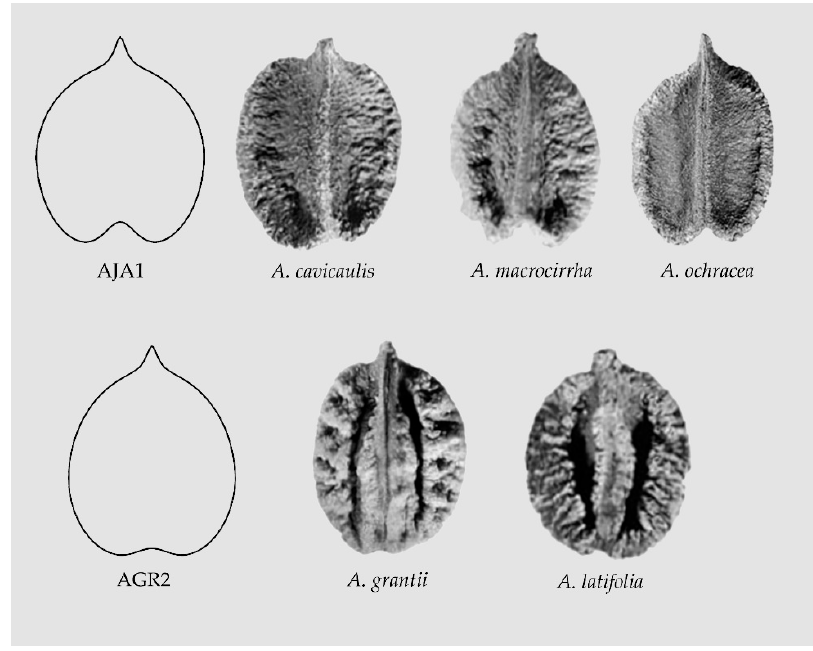
Figure 7. The seeds of many species of Ampelocissus are related with the Squared Heart Curve (SqHC). Model AJA1 adapts well to Ampelocissus cavicaulis , A. macrocirrha and A. ochracea. Model AGR2 represents better the shape of seeds of A. grantii and A. latifolia.